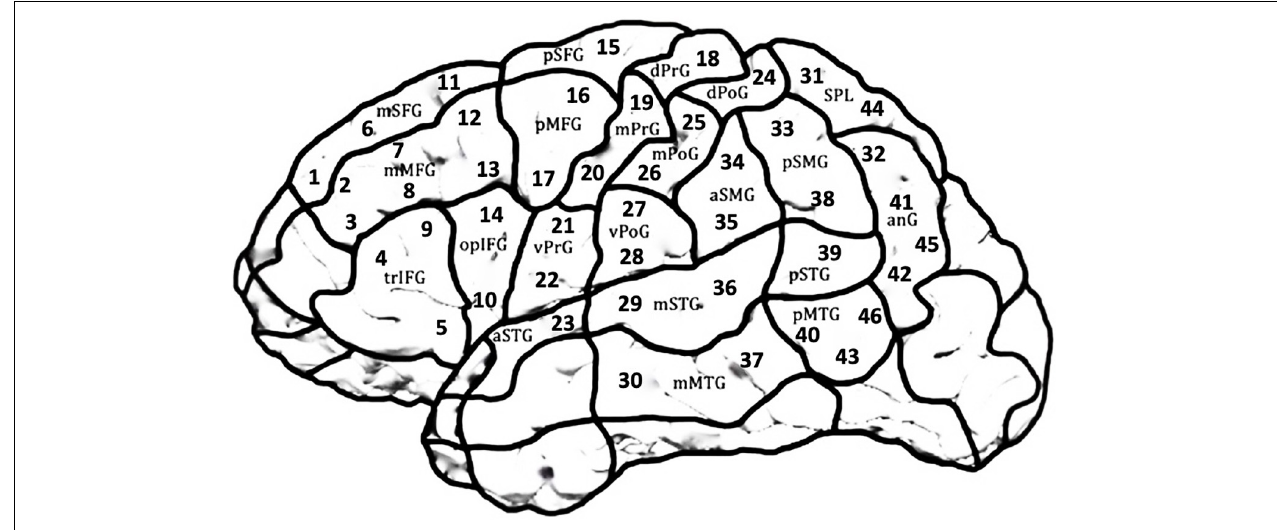
FIGURE 2 | Scheme of the LH covering the 21 cortical parcellation system (CPS) regions consisting of 46 stimulation targets. The same regions were targeted in the RH in a mirror-inverted fashion. Due to high discomfort during stimulation, occipital areas, frontal and temporal poles and inferior temporal regions were